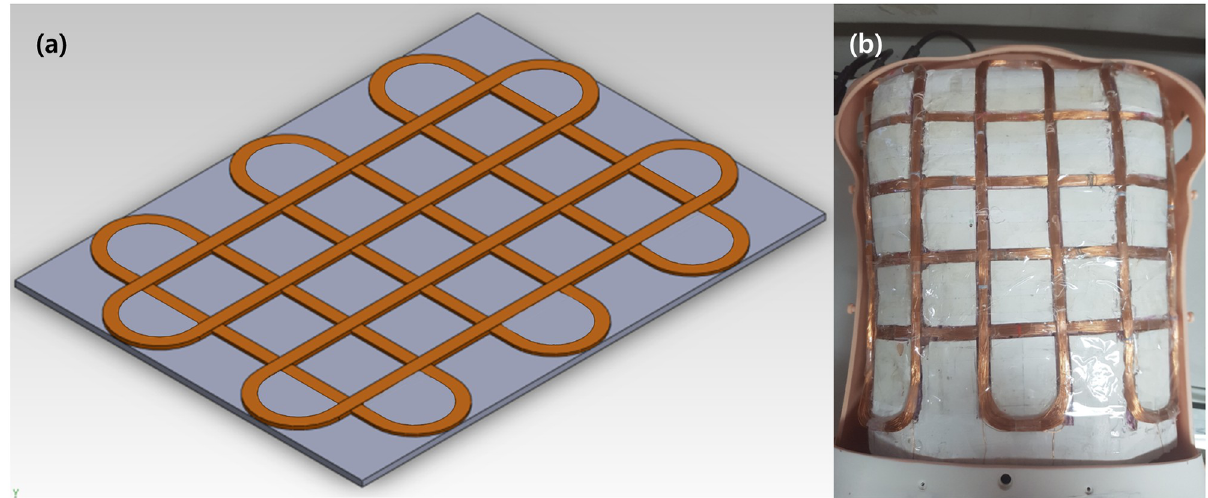
Fig 6. Modeling and Implemented chest manikin. (a) receiving coils array modeling using 3D CAD (b) fabricated chest manikin including receiving coils array.